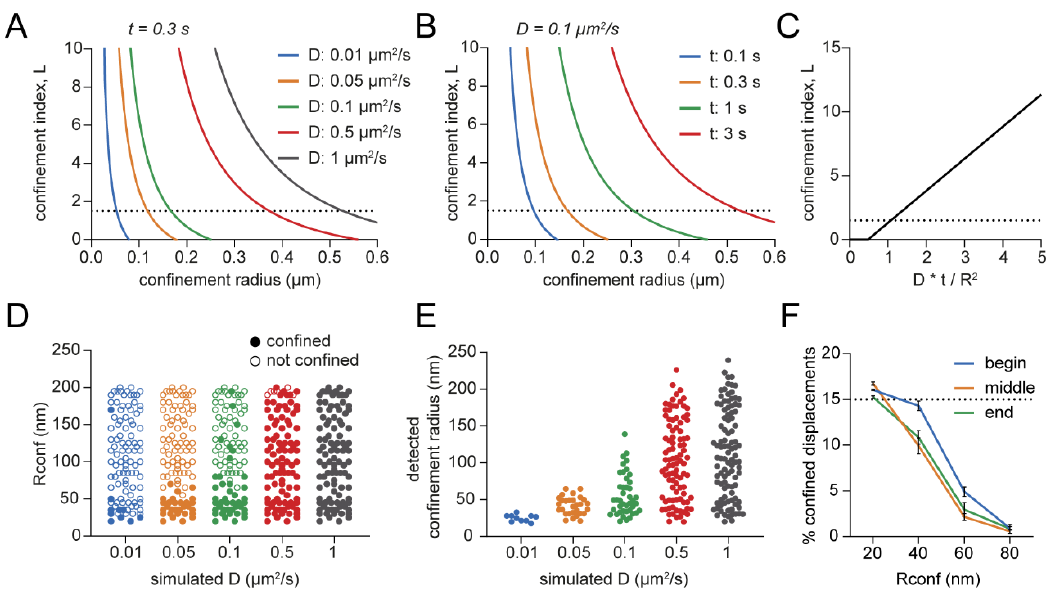
Figure 4. Detection limits of the confinement analysis. ( A ) Theoretical effect of the confinement radius and diffusion coefficient on the confinement index that can be detected. Observing time = 16 frames or 0.3 s. Dotted line indicates Lcm of 1.5 as used with Dset. ( B ) Theoretical effect of the confinement radius and observing time on the confinement index that can be detected. D = 0.1 μm 2 /s. ( C ) Theoretical relation between D × t/R 2 and the confinement index. ( D ) Effect of the diffusion coefficient in trajectories on the ability to detect a range of different simulated confinement radii ( Rconf ). ( E ) Effect of the diffusion coefficient in trajectories on the detected confinement radius given the same range of confinement radii in ( D ) as input for the simulations. ( F ) Effect of the timing of simulated confinement periods and Rconf on the correct detection of confinement. Fifteen frames confined of total 100 frames per simulated track. Five independent simulations of 100 trajectories per condition. Dotted line indicates correct confinement detection. Data are represented as means ± SD.